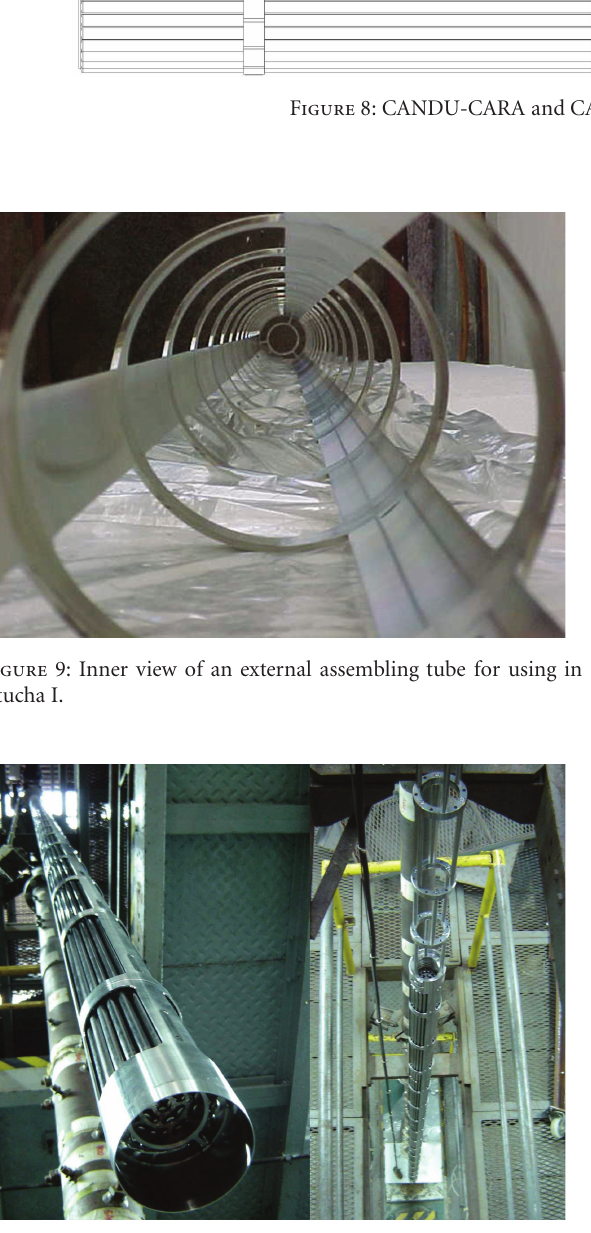
Figure 10: CARA Atucha FE